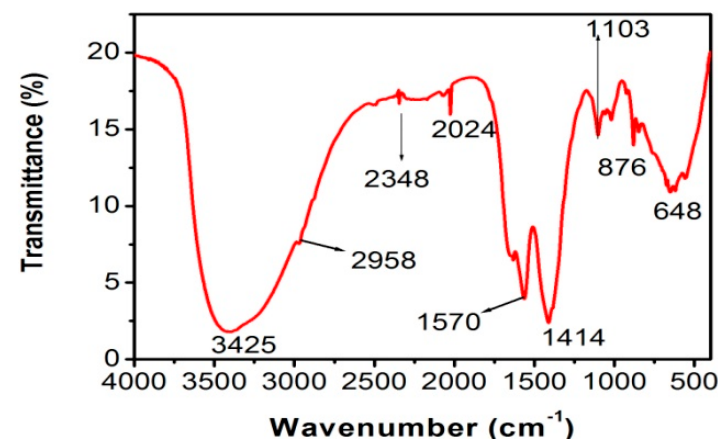
Figure 5. FT-IR spectrum of biosynthesized AgNPs.